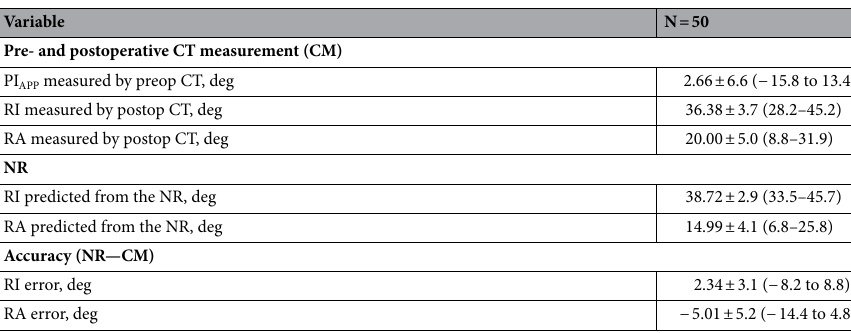
Table 2. Perioperative CT data and navigation records (NRs). The results for the continuous variables are presented as the means ± standard deviations with ranges in parentheses. CT computed tomography,